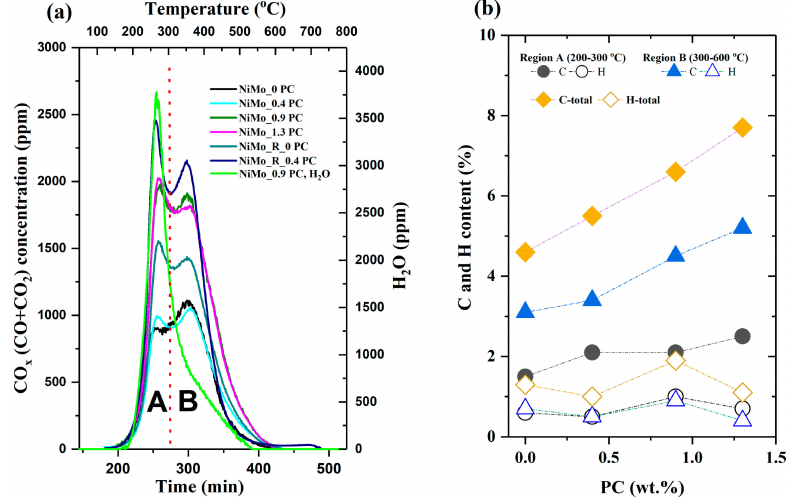
Figure 10. ( a ) CO, CO 2 , and H 2 O profile during TPO of the recovered catalyst; ( b ) measurement of carbon (C) and hydrogen (H) content (wt.%) of the recovered catalysts from